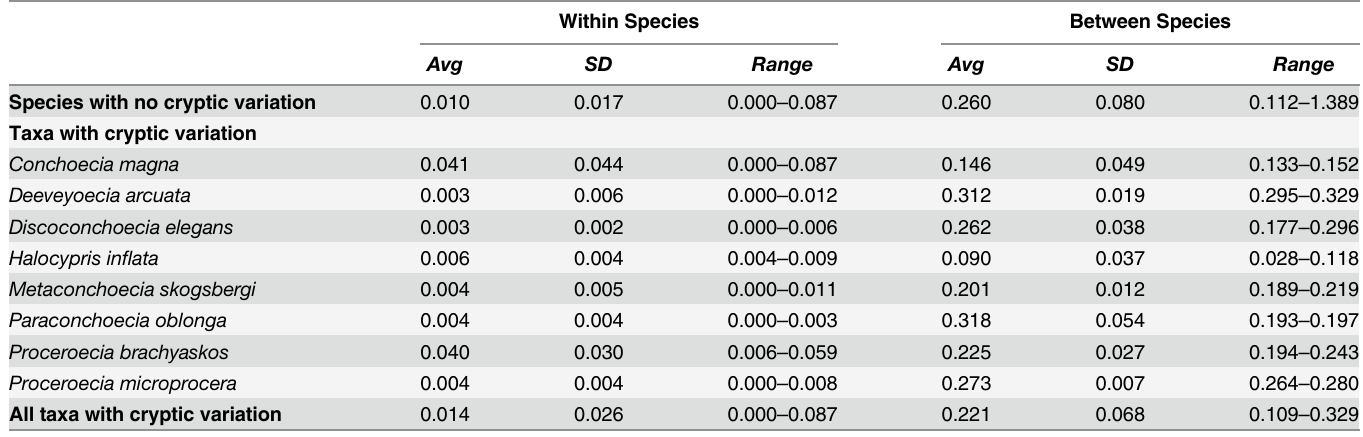
Table 1. Kimura-2-Parameter distances for within and between species comparisons of planktonic ostracods. Intraspecific and interspecific K2P dis- tances were calculated separately for taxa with and without cryptic variation. Eight taxa (putative species) hypothesized to comprise cryptic species-level vari- ation based on markedly high K2P distances were excluded from the first calculation of within and between species variation, which was then calculated for each of the eight taxa individually, with summary statistics for all eight taxa (putative species) hypothesized to comprise cryptic species. Additional information and explanation for many of these taxa is provided in the Results and